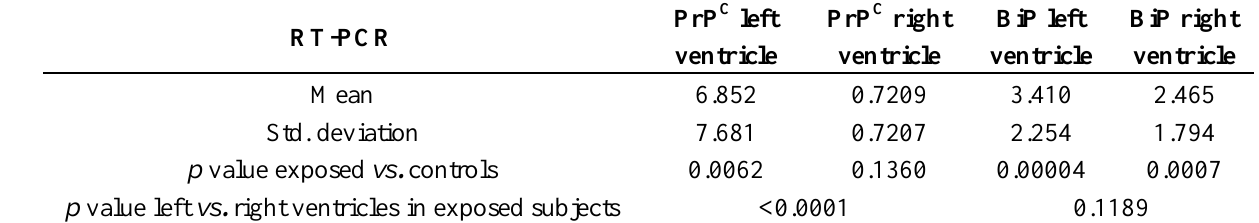
Table 2. RT-PCR results in Mexico City subjects expressed as mean ± SD fold increase vs. controls for PrP C and BiP/GRP78 in right and left ventricles. PrP C left ventricular expression is significantly different from controls ( p = 0.006). BiP/GRP78 left and right ventricular expression is significantly different from controls. There is a significant difference in the expression of PrP C between the left and the right ventricles in Mexico City subjects ( p < 0.0001).